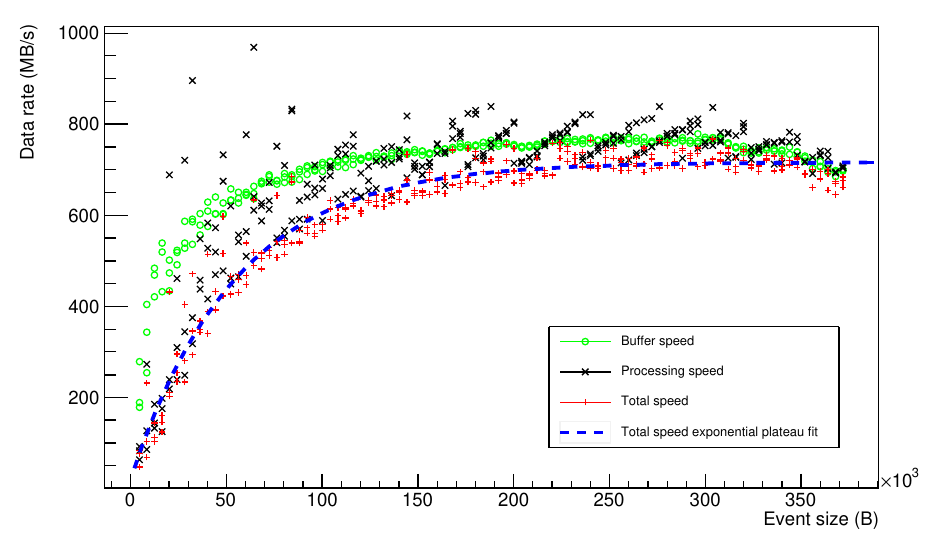
Figure 5. Readout performance results for a single Slave readout process running on a single readout server. Bu ff er speed represents performance of all logic leading up to the processing stage, processing speed represents performance of the processing stage (c.f. [7]), and total speed combines the